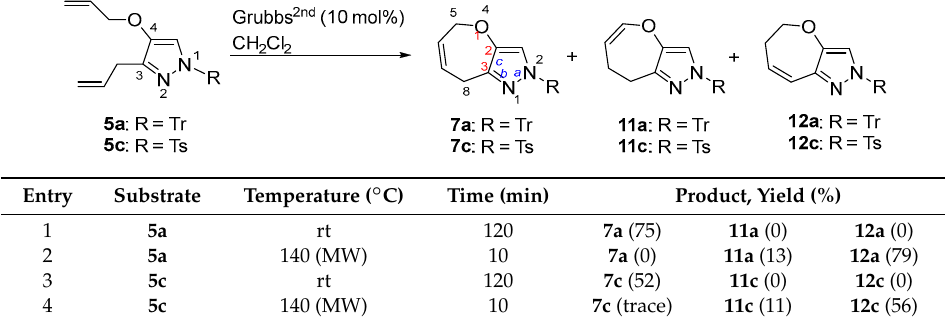
Table 4. RCM of 1-substituted 4-allyloxy-3-allyl-1 H -pyrazoles.